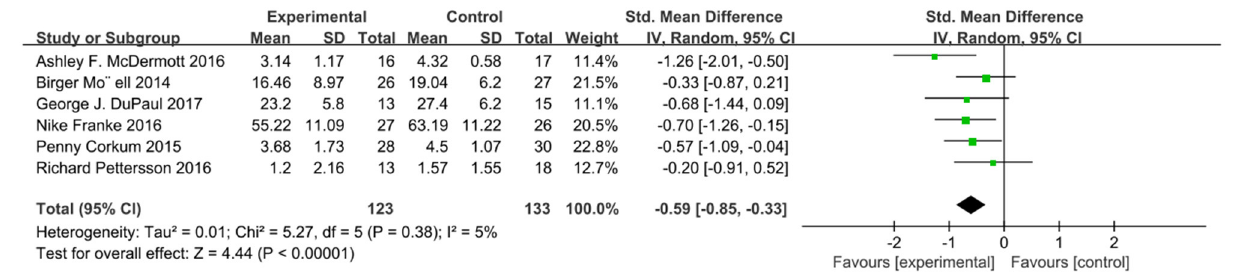
FIGURE 3 | Social function score of online intervention ADHD compared with waiting list.